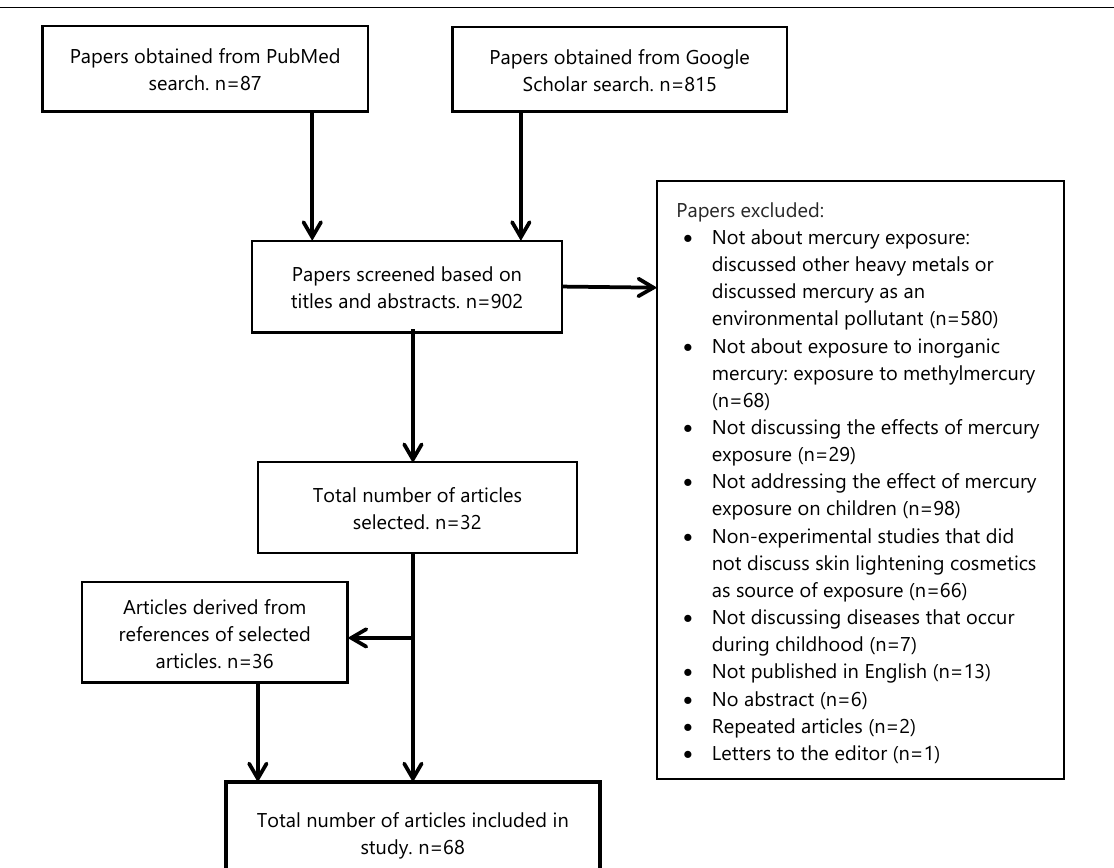
Figure 1. Search Results and Exclusion of